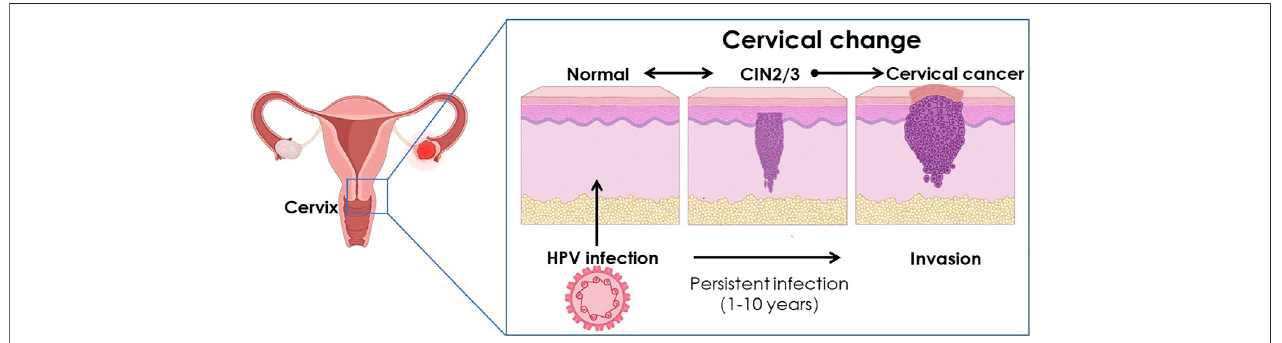
FIGURE 2 | Schematic illustration of the cervical change caused by HPV